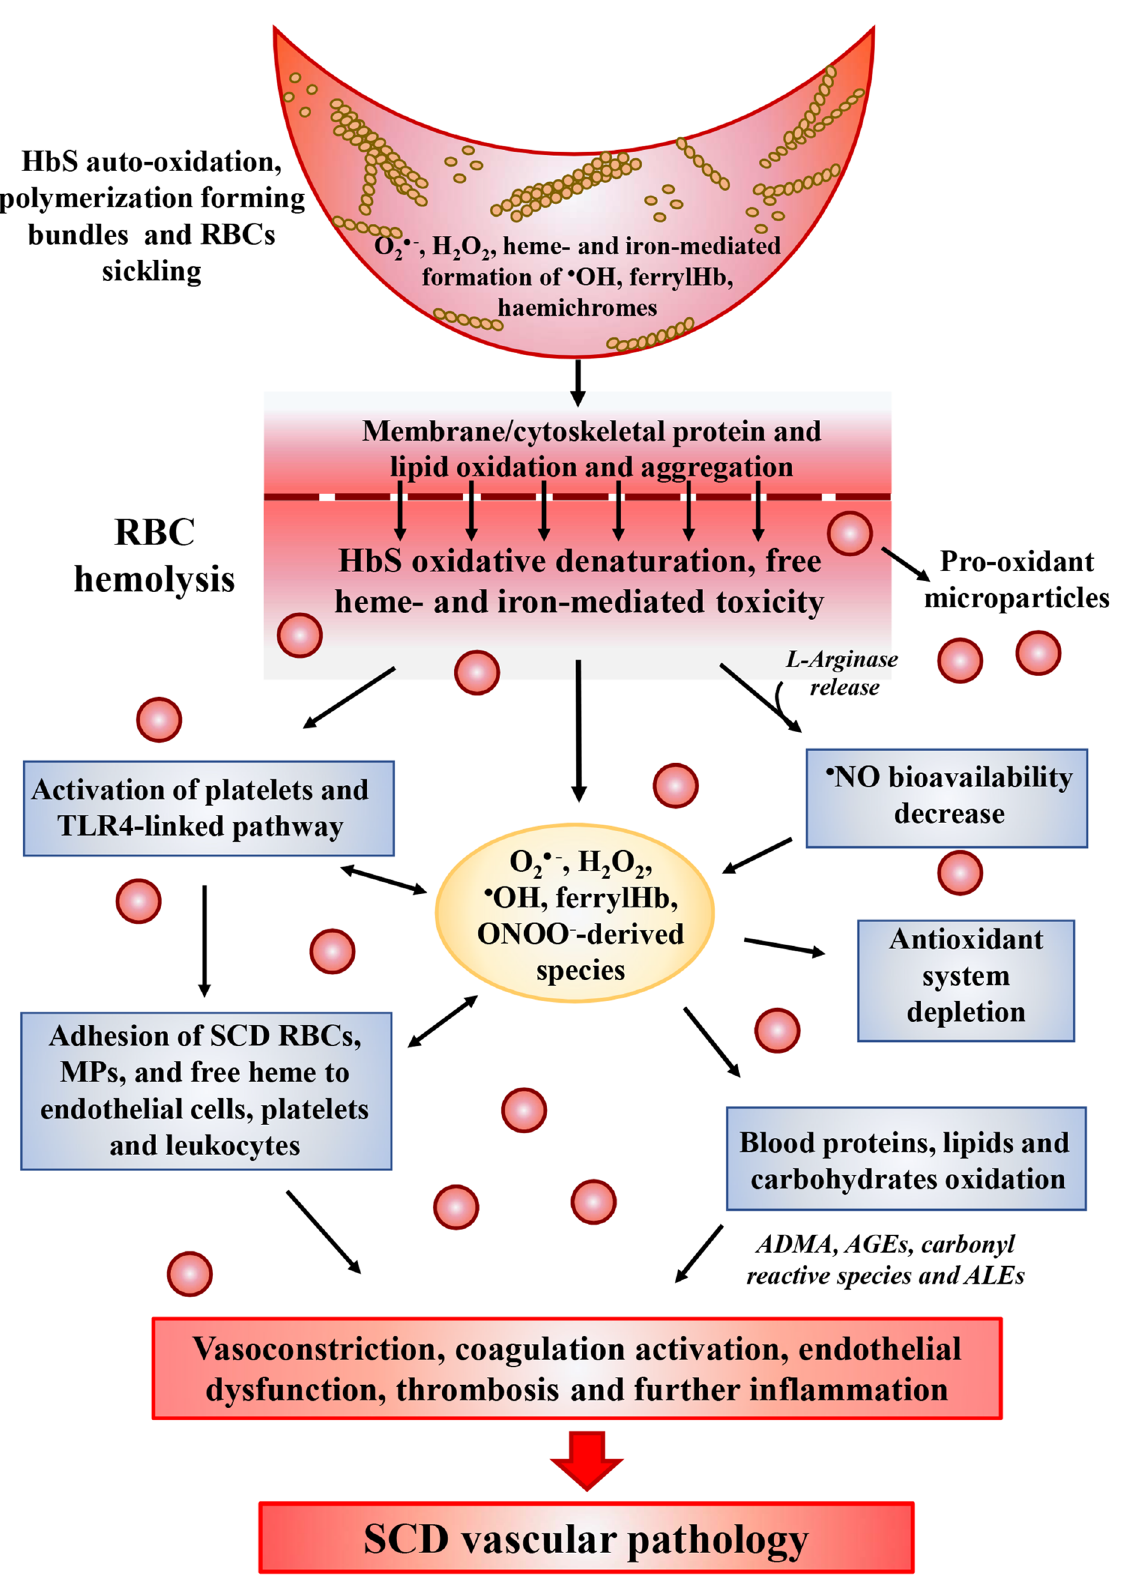
Figure 1. Pathophysiological effects of oxidative stress in sickle cell disease (SCD). Following oxygenation/deoxygenation cycles, HbS in RBCs undergoes autoxidation generating reactive oxidizing H 2 O 2 and the release of free heme and iron. Heme and iron are key players in SCD oxidative damage by (i) catalyzing the generation of strong oxidizing • OH and ferrylHb through the H 2 O 2 -dependent Fenton reaction; (ii) boosting platelets activation and adhesion to endo-